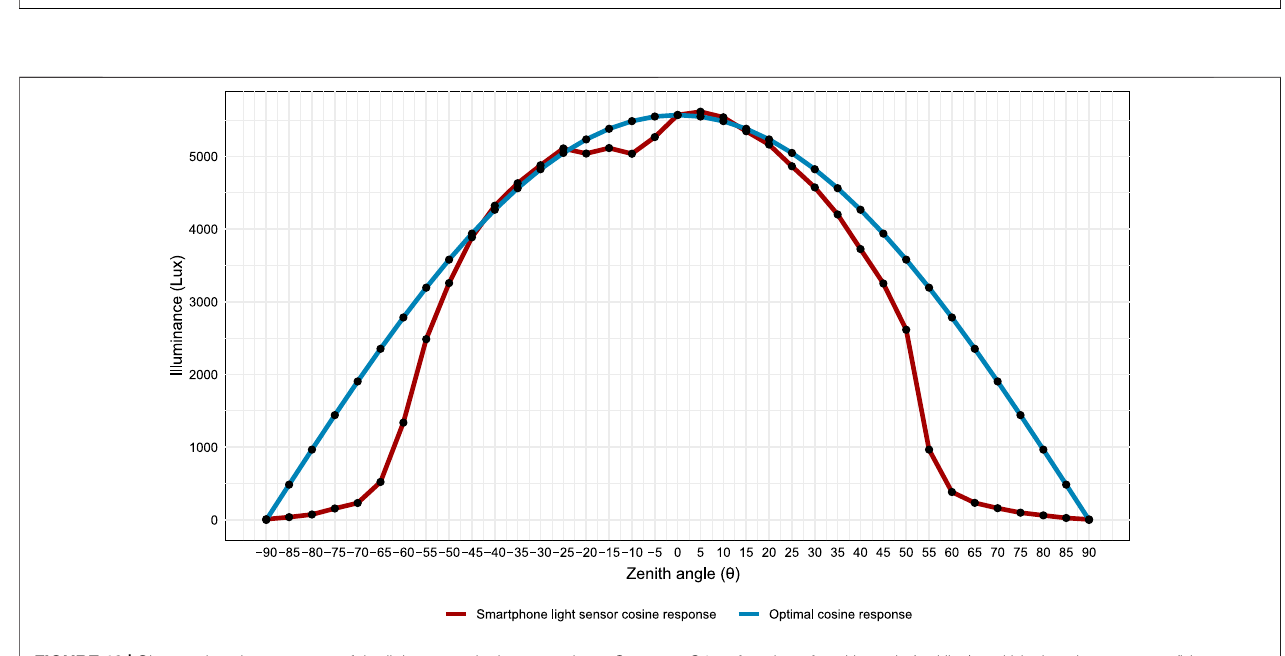
FIGURE 10 | Observed cosine response of the light sensor in the smartphone Samsung S4 as function of zenith angle (red line) and ideal cosine response (blue line).